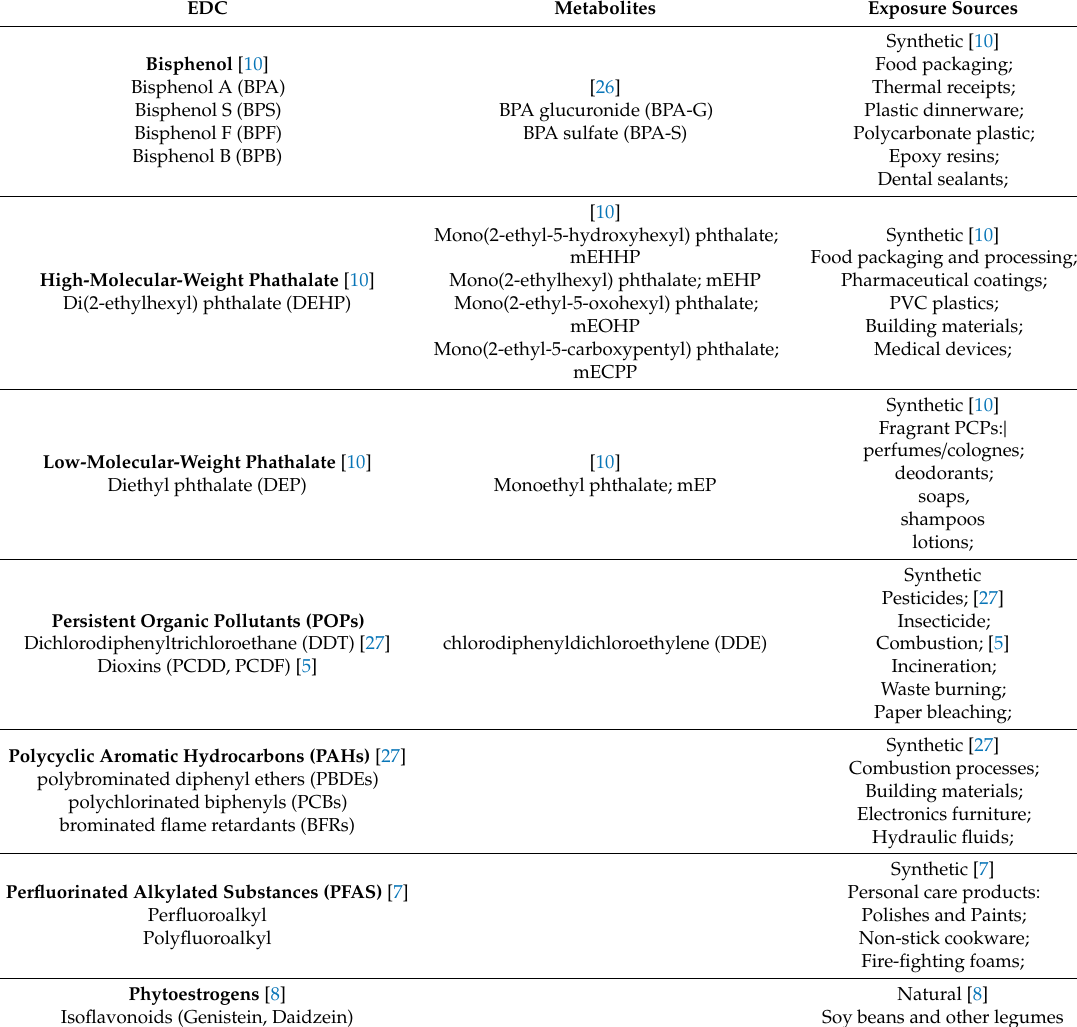
Table 1. Endocrine-disrupting chemicals (EDCs) most relevant to human